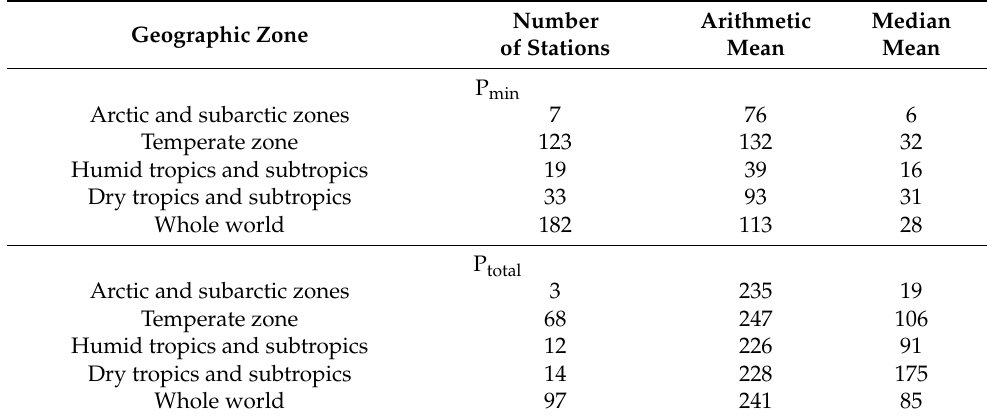
Table 10. The average content of dissolved phosphorus (µg/L) in the river waters of different geo- graphic zones [50,51].